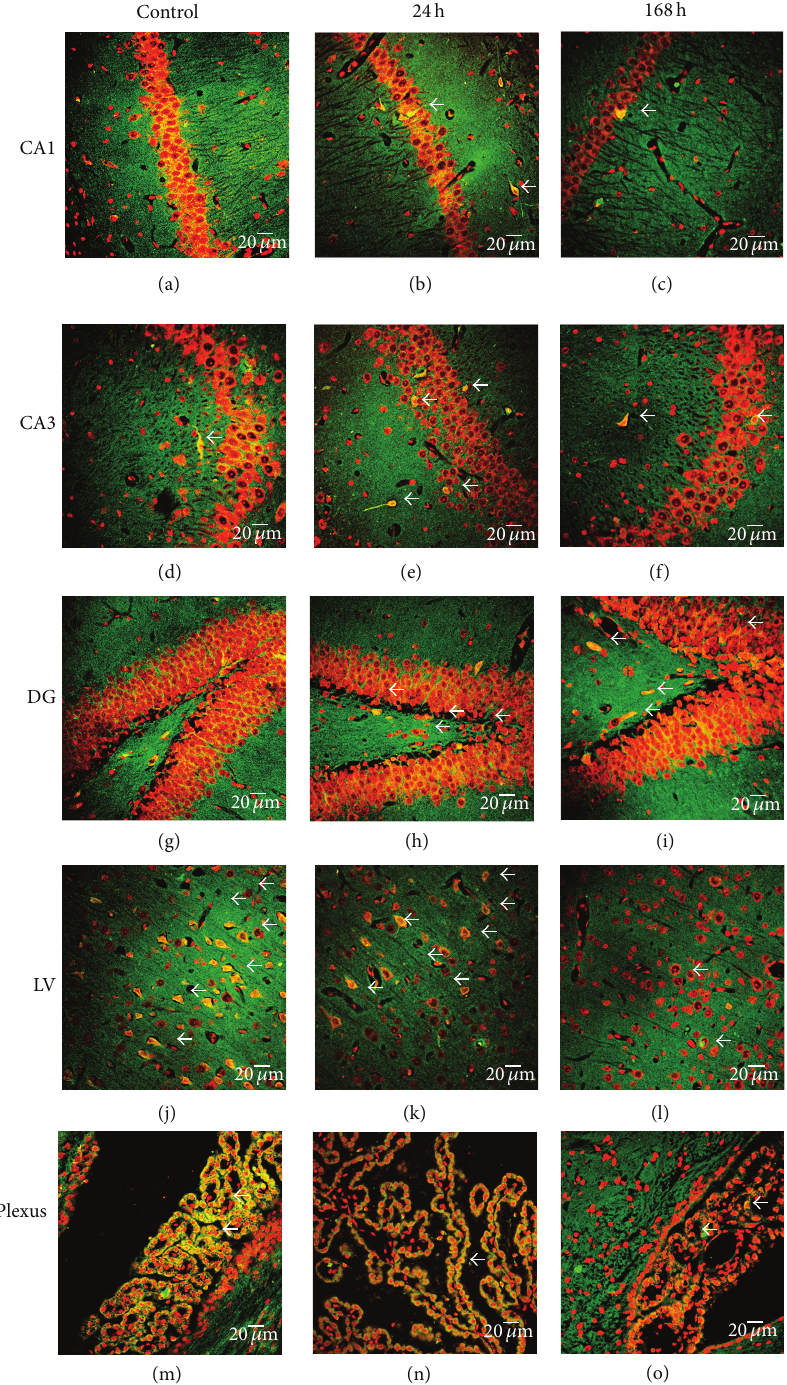
Figure 3: Effect of common carotid artery occlusion on the immunoreactivity against CCR2. Representative micrographs of CCR2 immunofluorescence ((a) to (o)) using a rabbit antibody against CCR2 and a goat antibody anti-rabbit IgG conjugated with fluorescein isothiocyanate (green color). The cerebral region was identified by propidium iodide (red color) counterstaining. CA, Cornu Ammonis, and DG, dentate gyrus, of the hippocampus. LV, layer V of the cerebral cortex. Plexus, choroid plexus. Values are the mean ± SEM from 3 rats in each experimental